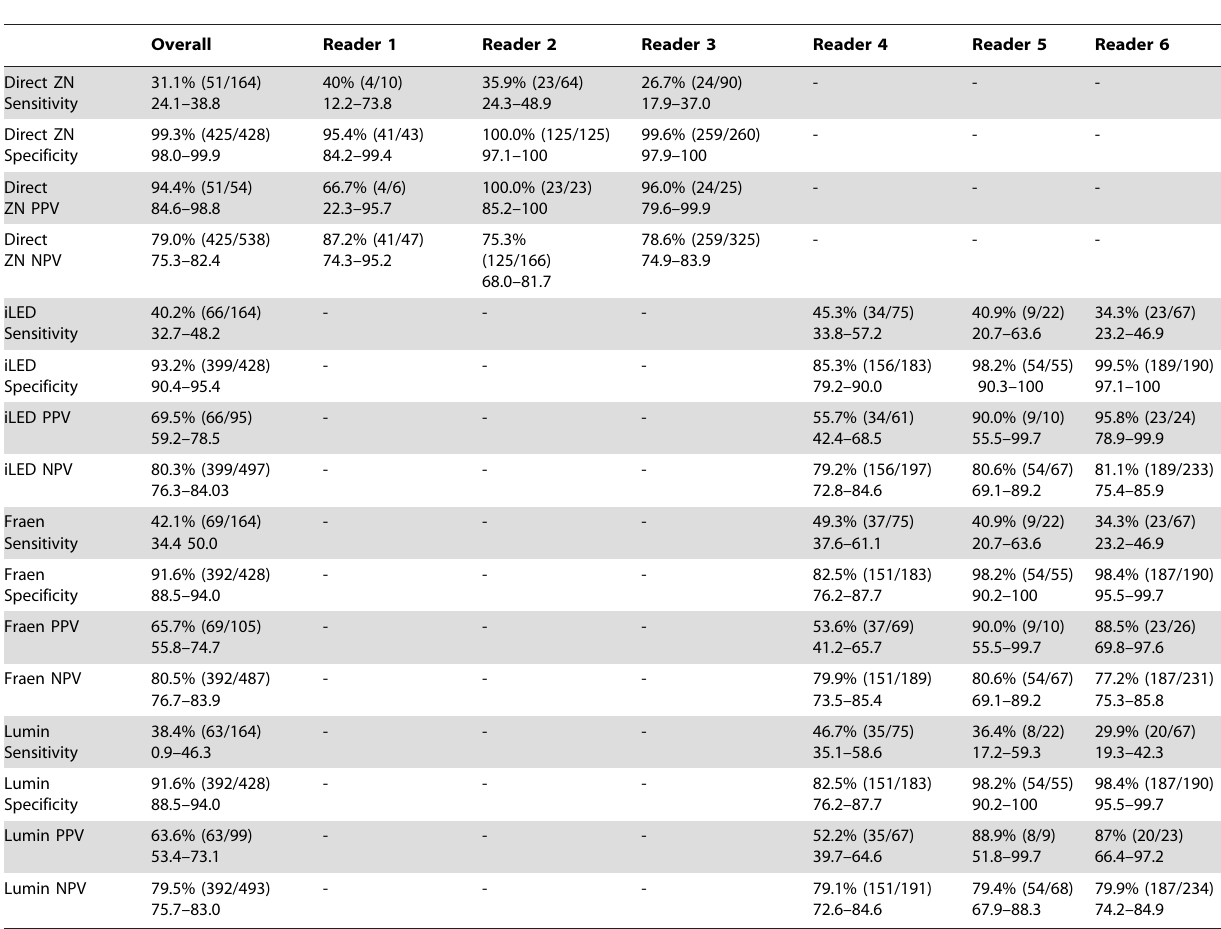
Table 3. Per reader analysis of performance of ZN and LED-based fluorescence microscopy methods, per specimen